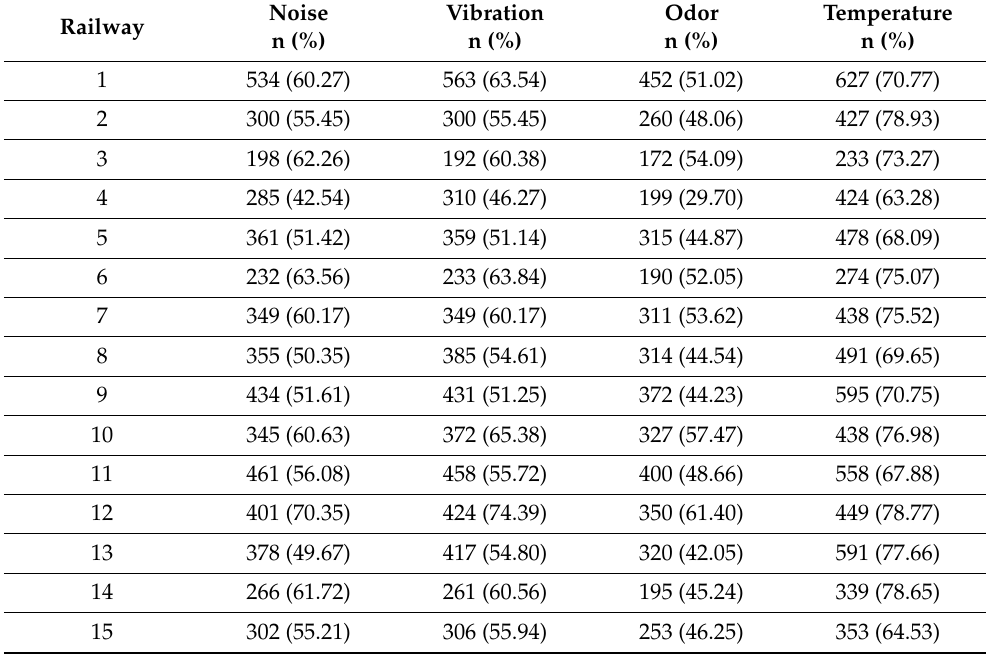
Table 1. Workplace exposure risk factors by railway.